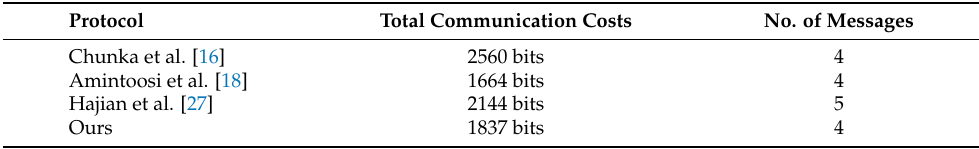
Table 5. Communication cost of login and authentication